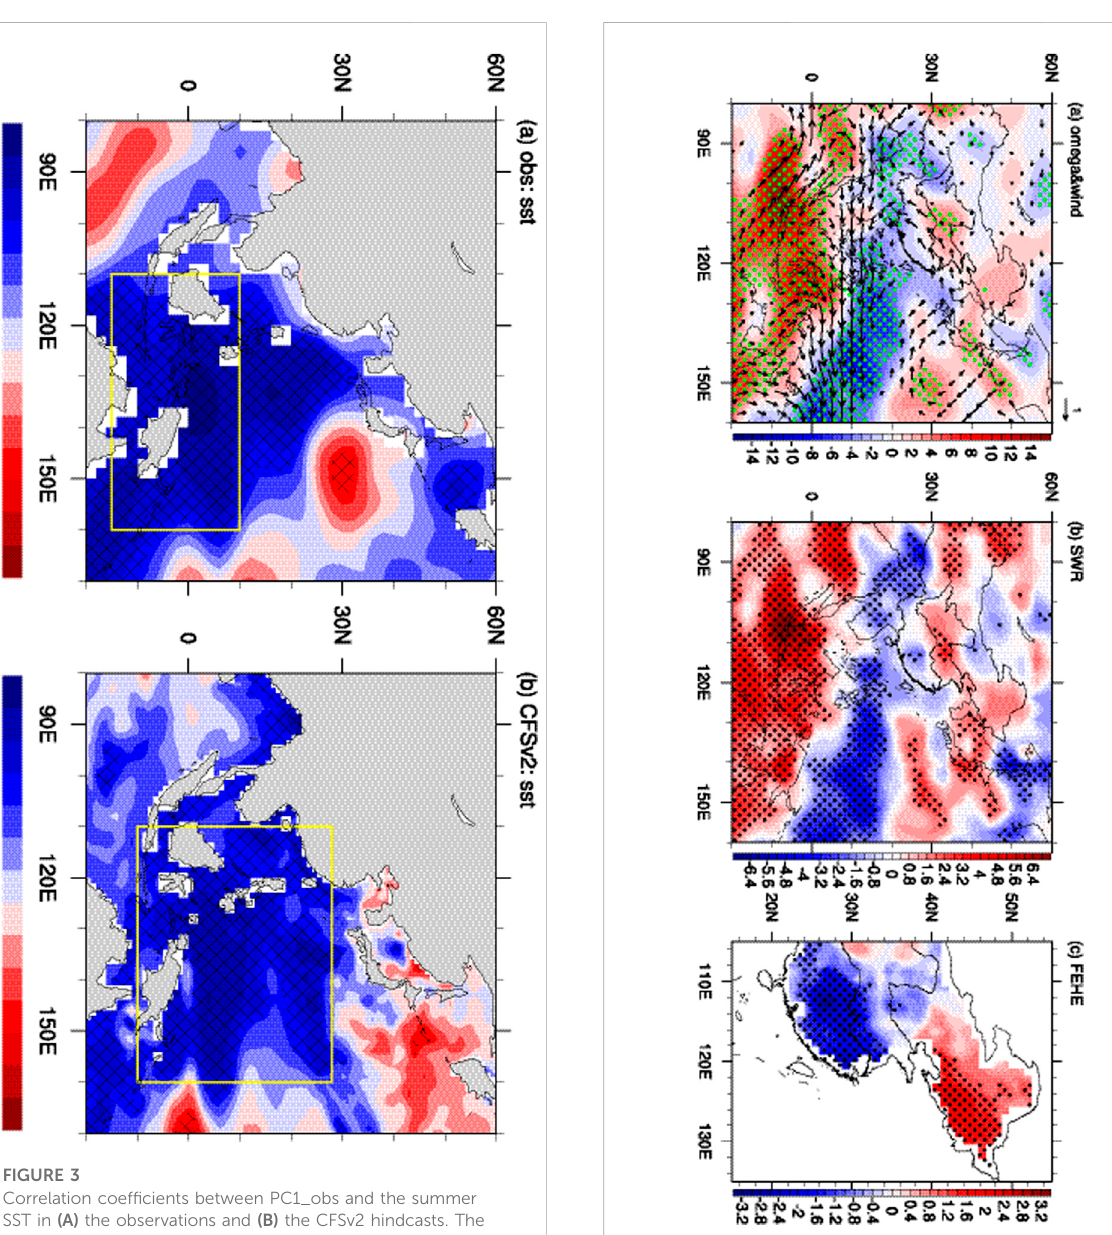
FIGURE 3 Correlation coef fi cients between PC1_obs and the summer SST in (A) the observations and (B) the CFSv2 hindcasts. The meshes denote the correlation coef fi cients signi fi cant at the 95% con fi dence level based on Student ’ s t -test. FIGURE 4